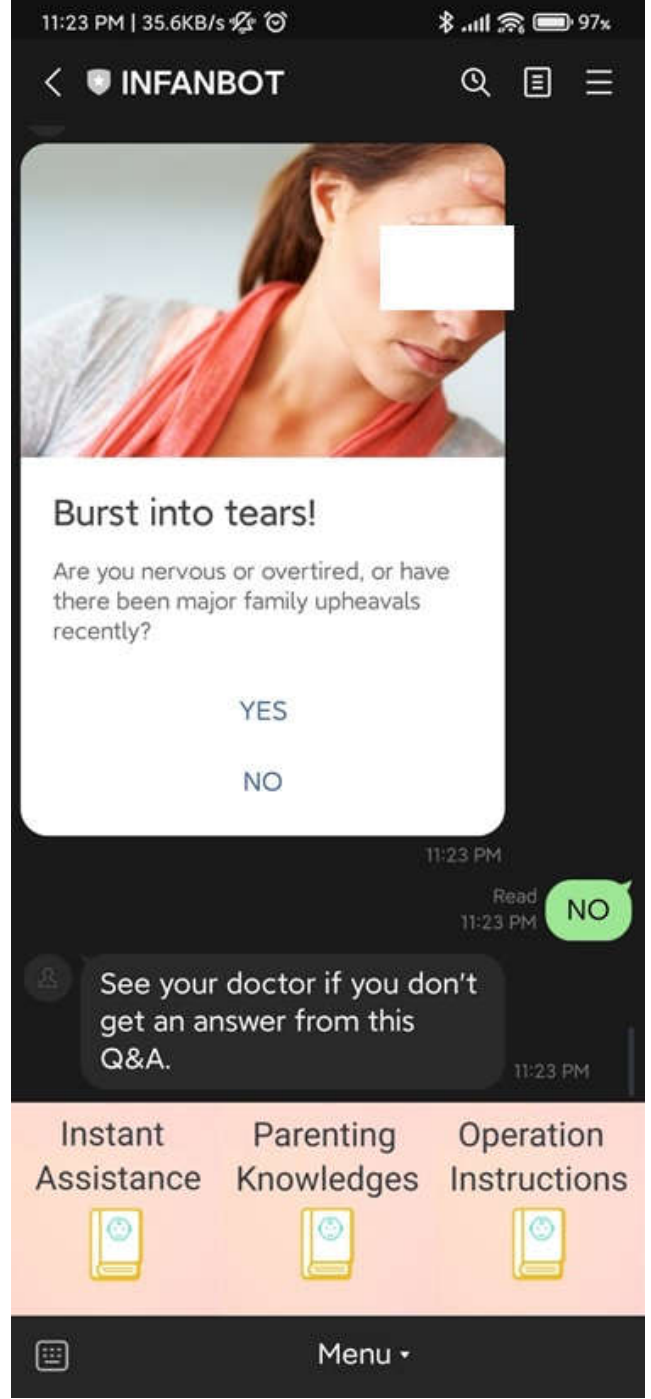
Figure 8. Seek medical